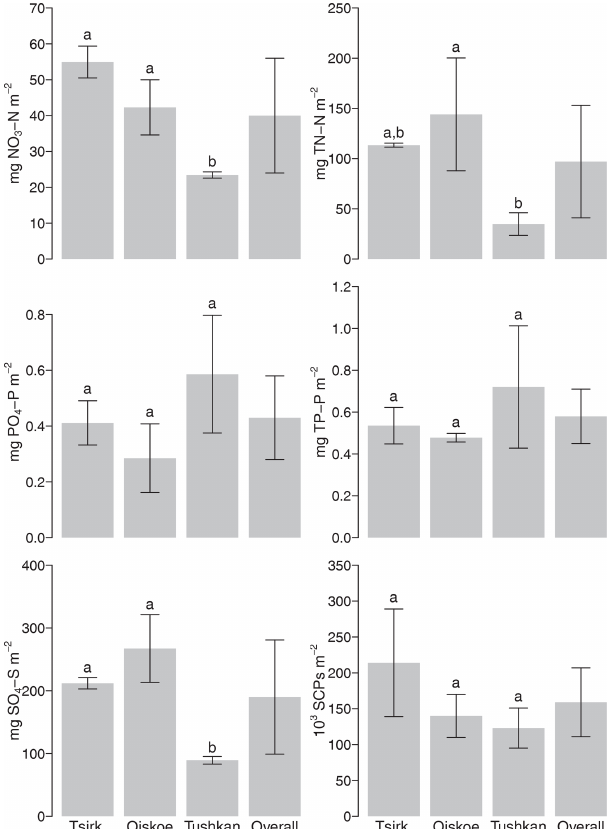
Figure 4. Half-year deposition of some airborne chemical species along with snow at three different sites in the Ergaki mountain ridge. Bars are average values, and whiskers represent the standard devi- ation. Sites with different letters on error bars belong to different groups defined by post hoc Tukey HSD (honestly significant differ- ence) analysis (one-way ANOVA p <